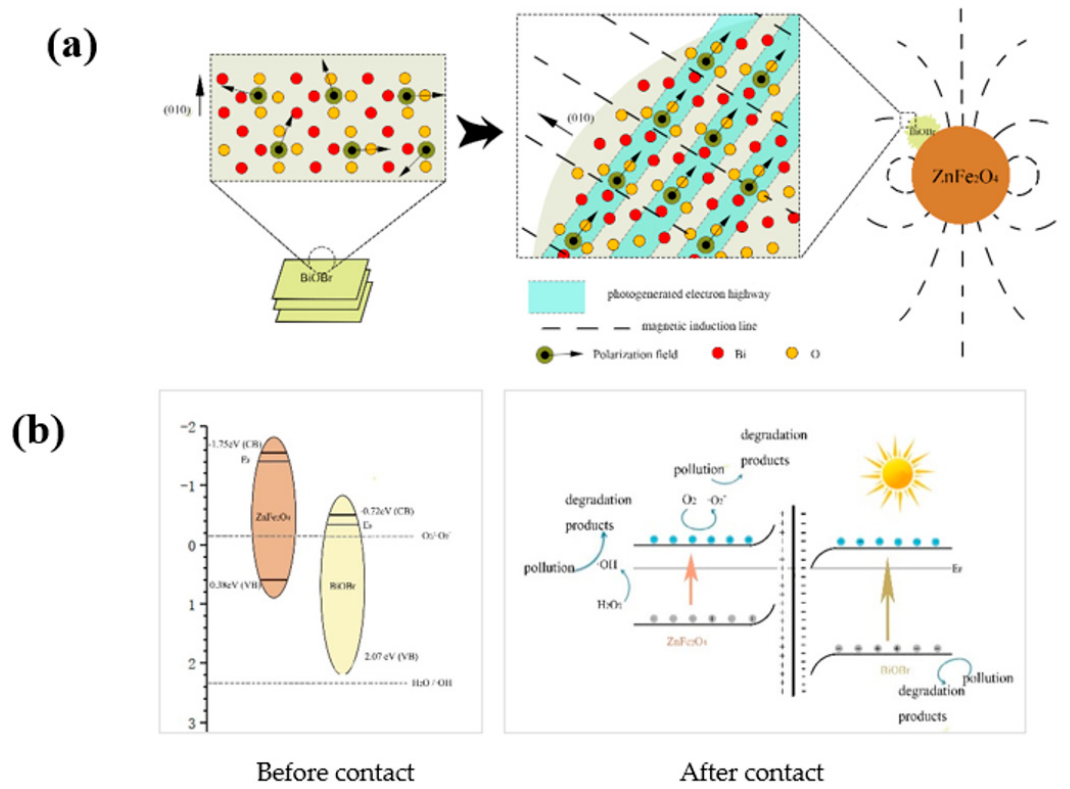
Figure 11. ( a ) The proposed different transportation route of photogenerated charges over pure BiOBr and BOB/ZFO composite (in which the BiOBr is epitaxial grown); ( b ) The band structure variation before and after the heterojunction formation and the enhanced mechanism of built-in electric